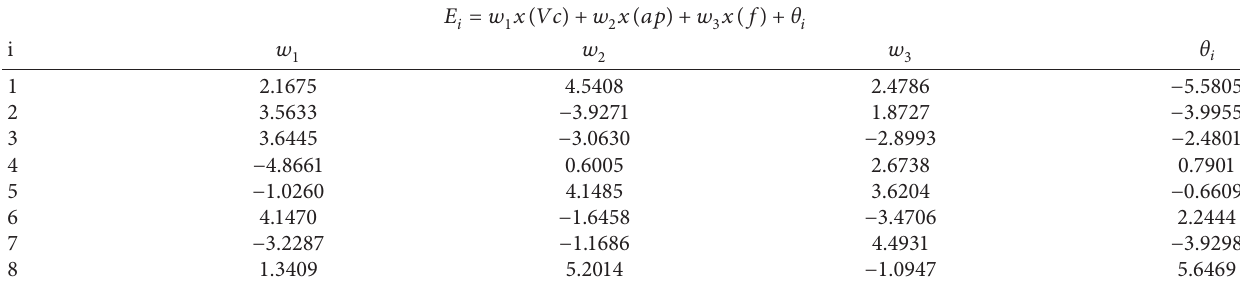
Table 4: Weight values between the hidden and input layers for surface roughness.